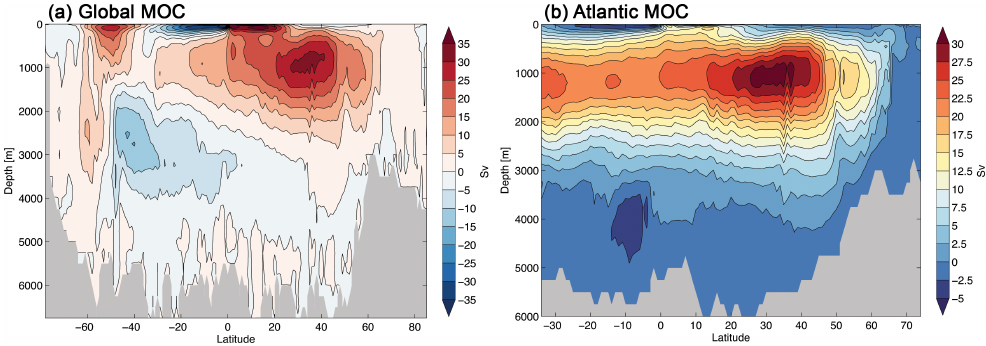
Fig. 13. Simulated meridional overturning circulation of piControl (years 826–855) represented with stream functions (Sv) for the (a) global and (b) Atlantic domain.